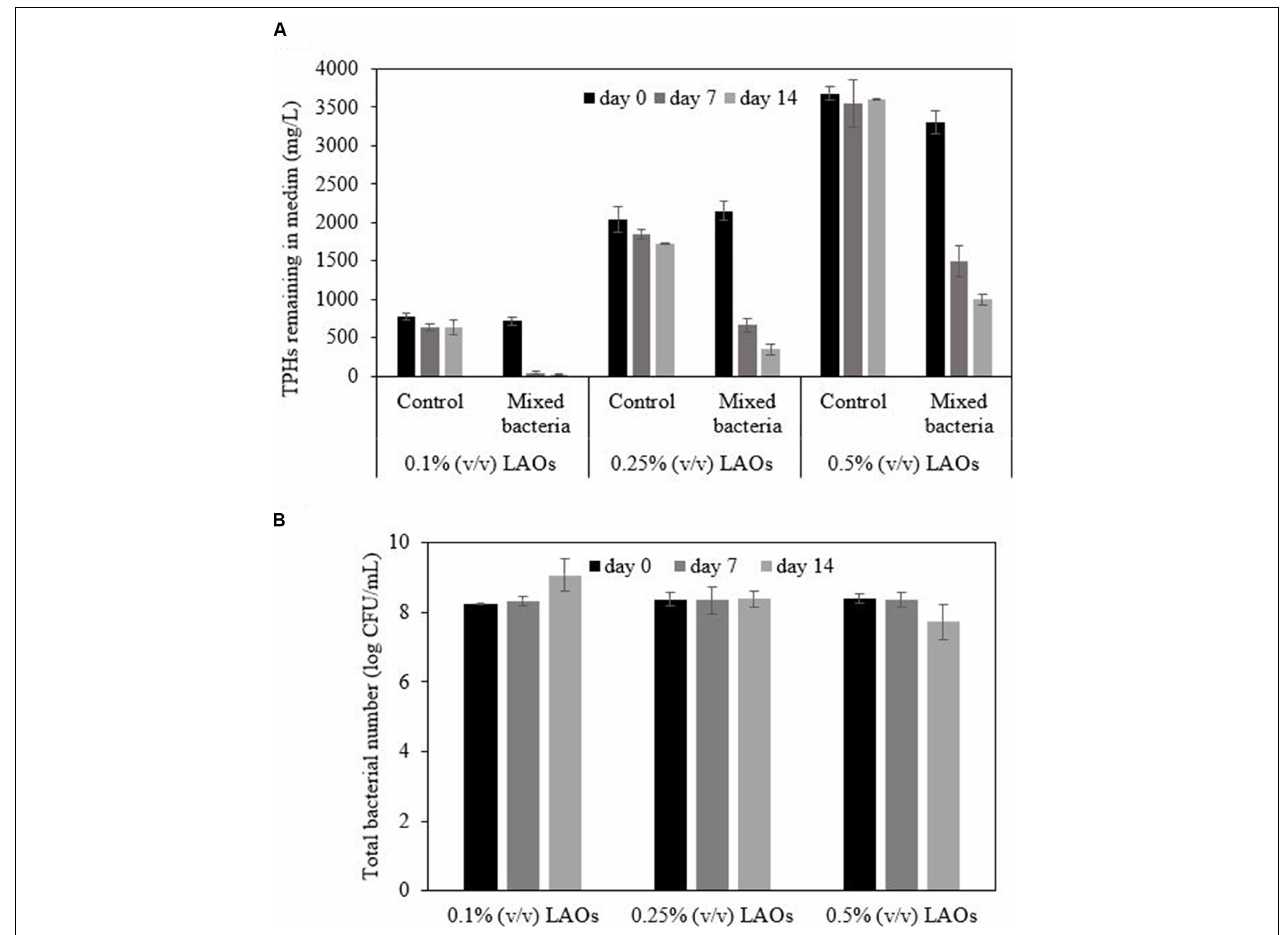
FIGURE 5 | Degradation of polyolefin (LAOs) by mixed bacterial inoculum in MSM medium containing 0.5% NaCl (A) and the changes in bacterial number during the experiment (B) .